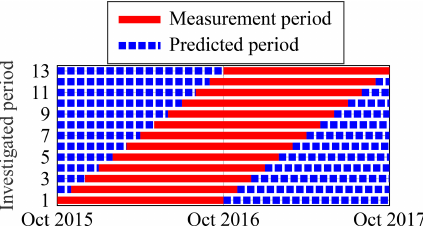
Figure 12. Visualisation of the 13 different 1-year periods for sta- tistical